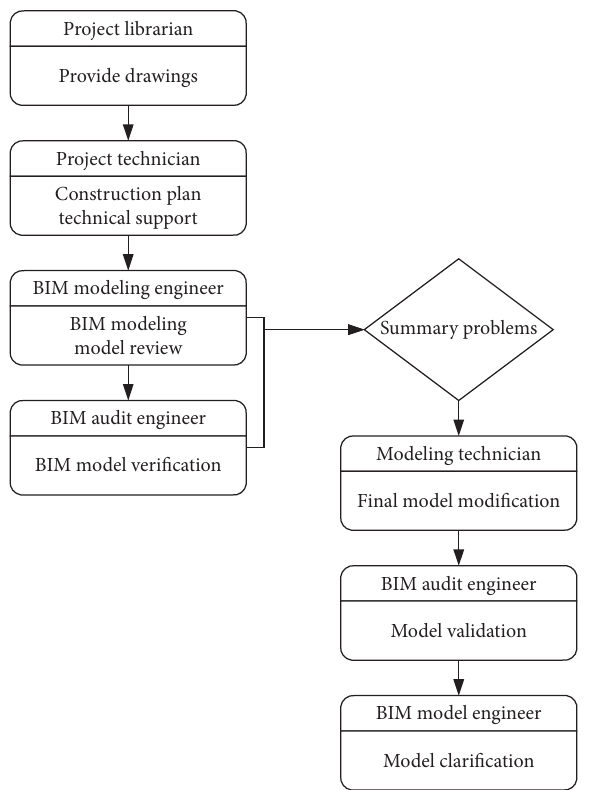
Figure 9: The flow chart for the development of 3D BIM.